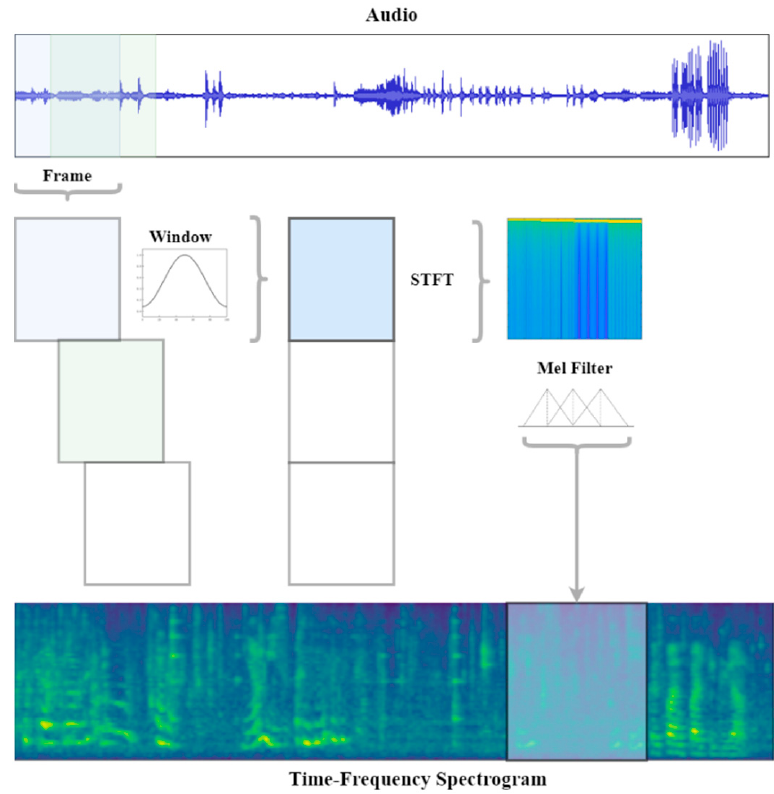
Figure 4. The processing steps from original audio to the Mel spectrogram.